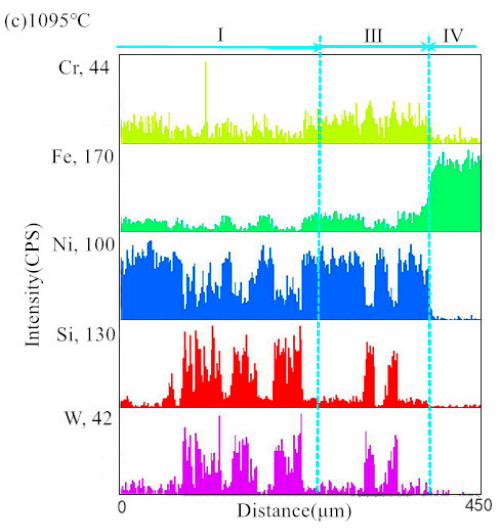
Figure 8. Element distribution at the brazed interface: ( a ) 1015 ◦ C; ( b ) 1055 ◦ C; and ( c ) 1095 ◦ C.